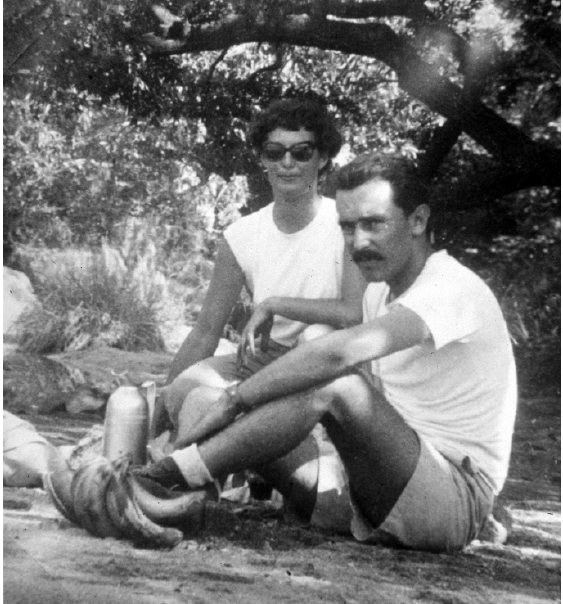
Figure 1. Maria Carlota Quintanilha and her husband, João José Tinoco, Portuguese Africa, circa 1953–1966. (Credits: Author’s archives).